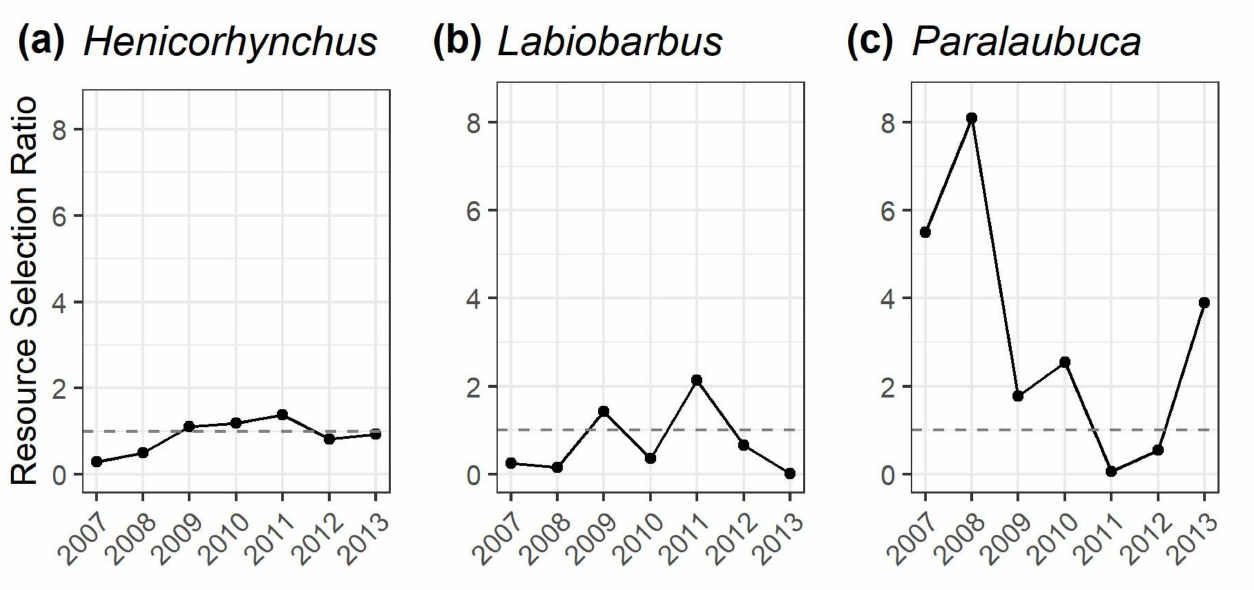
Figure 4. Resource selection ratios for the three most common genera, ( a ) Henicorhynchus , ( b ) Labiobarbus , and ( c ) Paralaubuca , representing selection the gillnet fishery relative to the Dai fishery. Grey dashed line is at 1, representing when the genera is caught equally in both